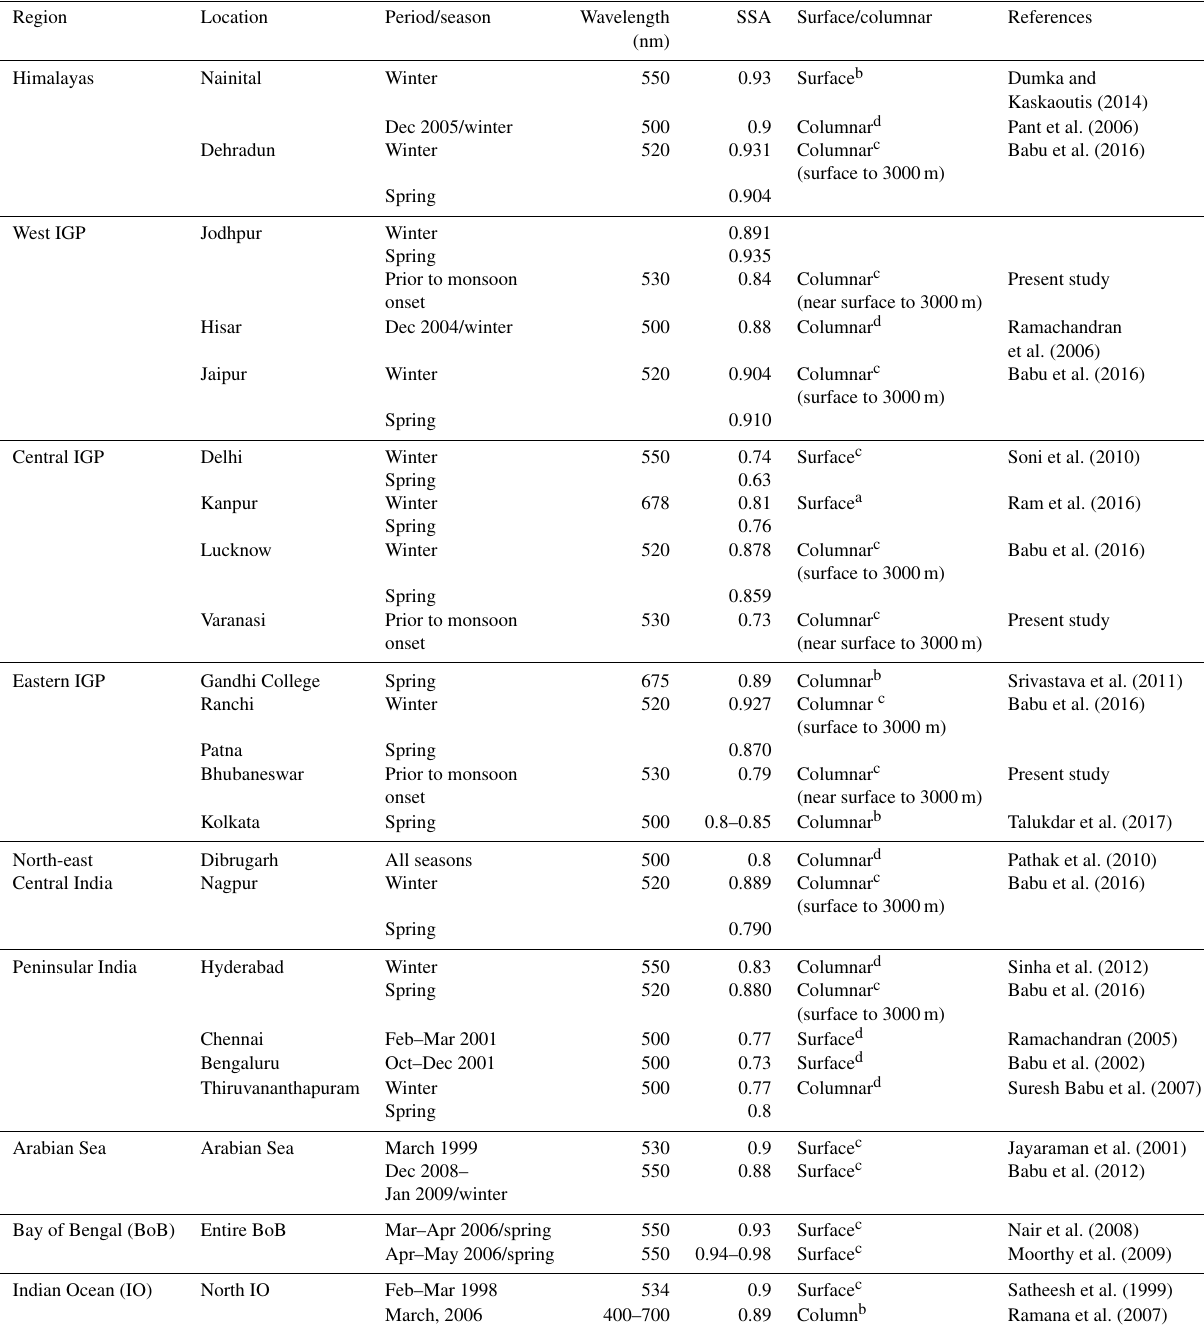
Table 3. SSA values reported over the Indian landmass and adjoining oceans.